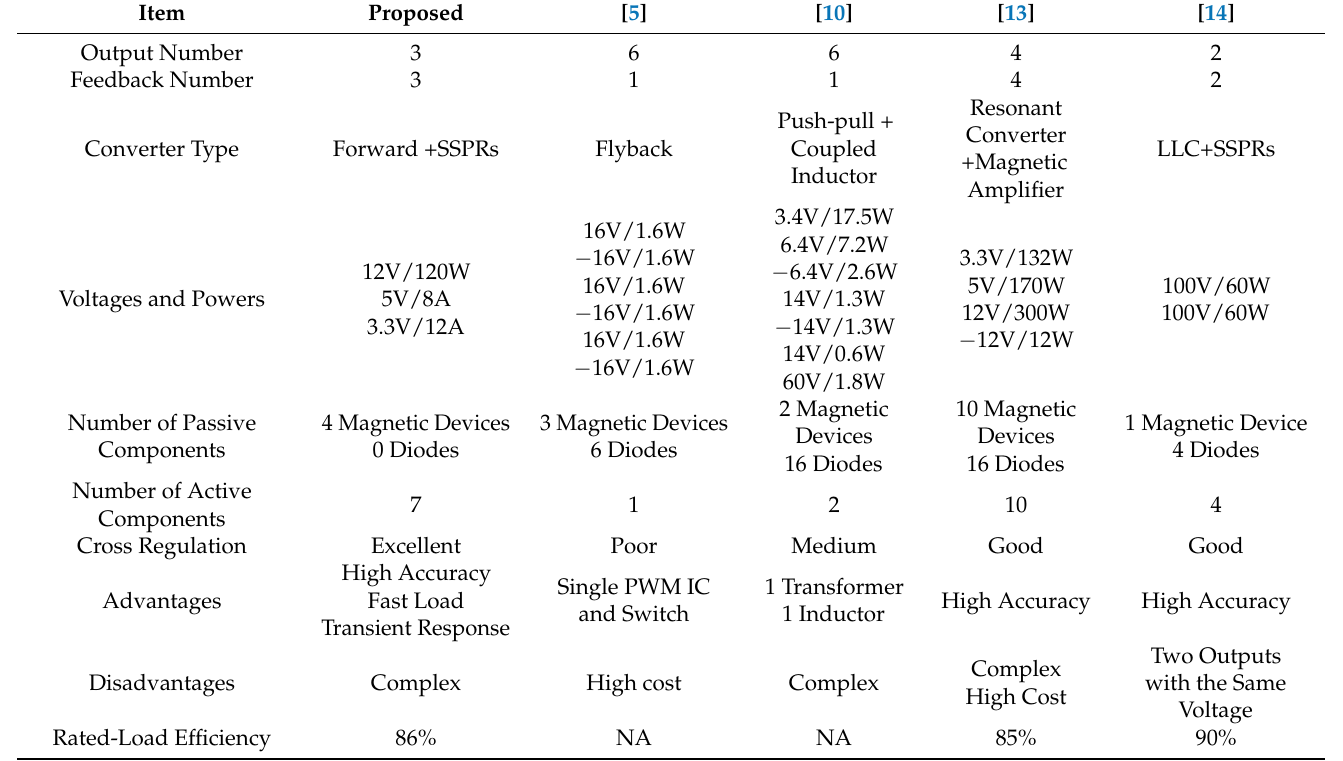
Table 5. Comparisons between the proposed circuit and the existing